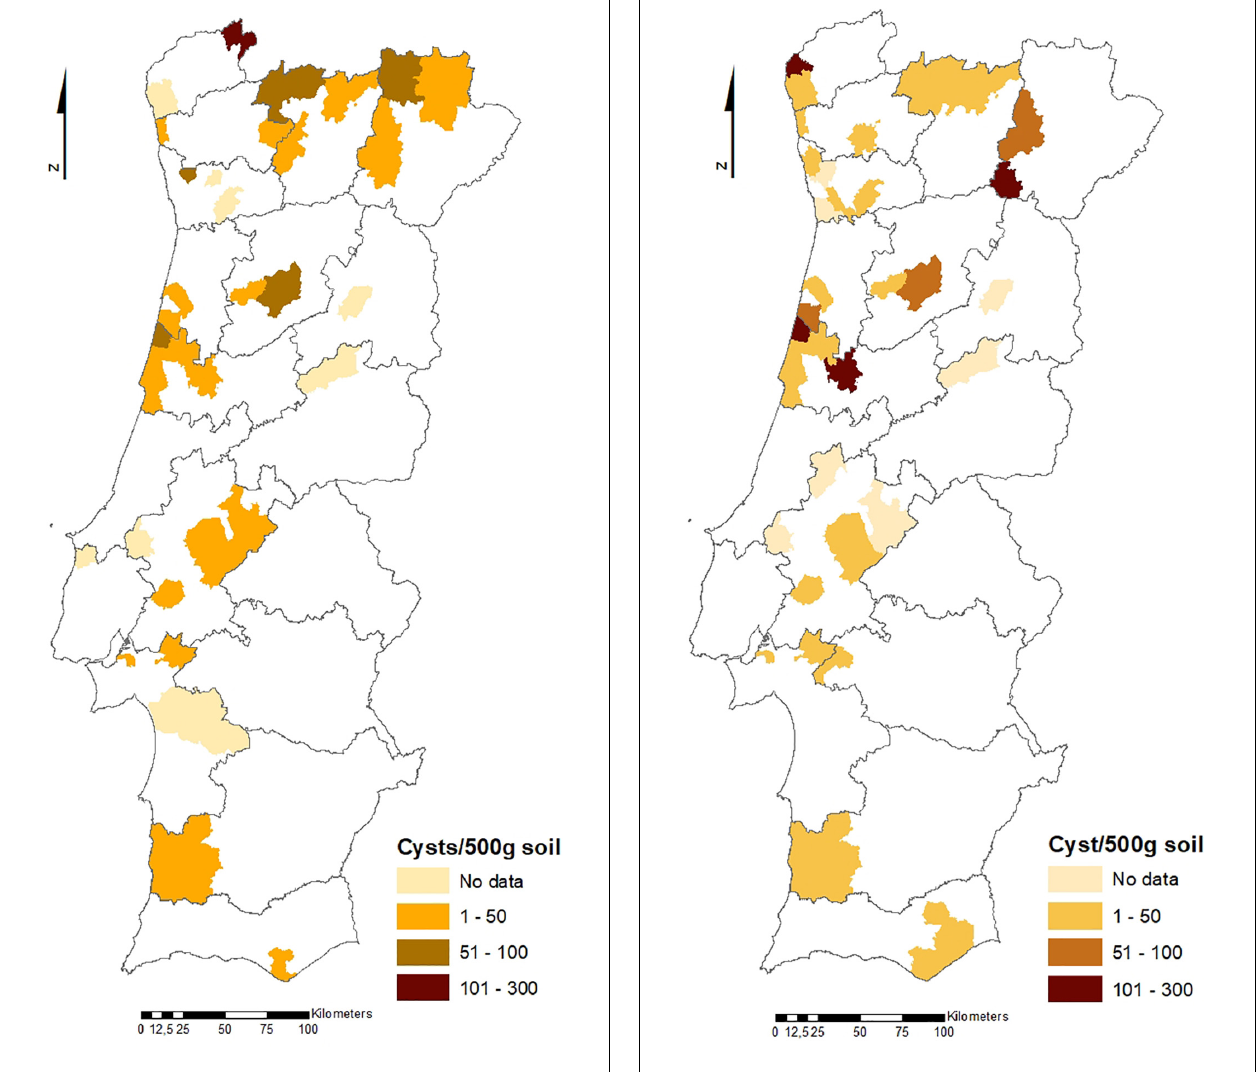
FIGURE 3 | Counties with positive detections of Globodera pallida in Portugal between 2013 and